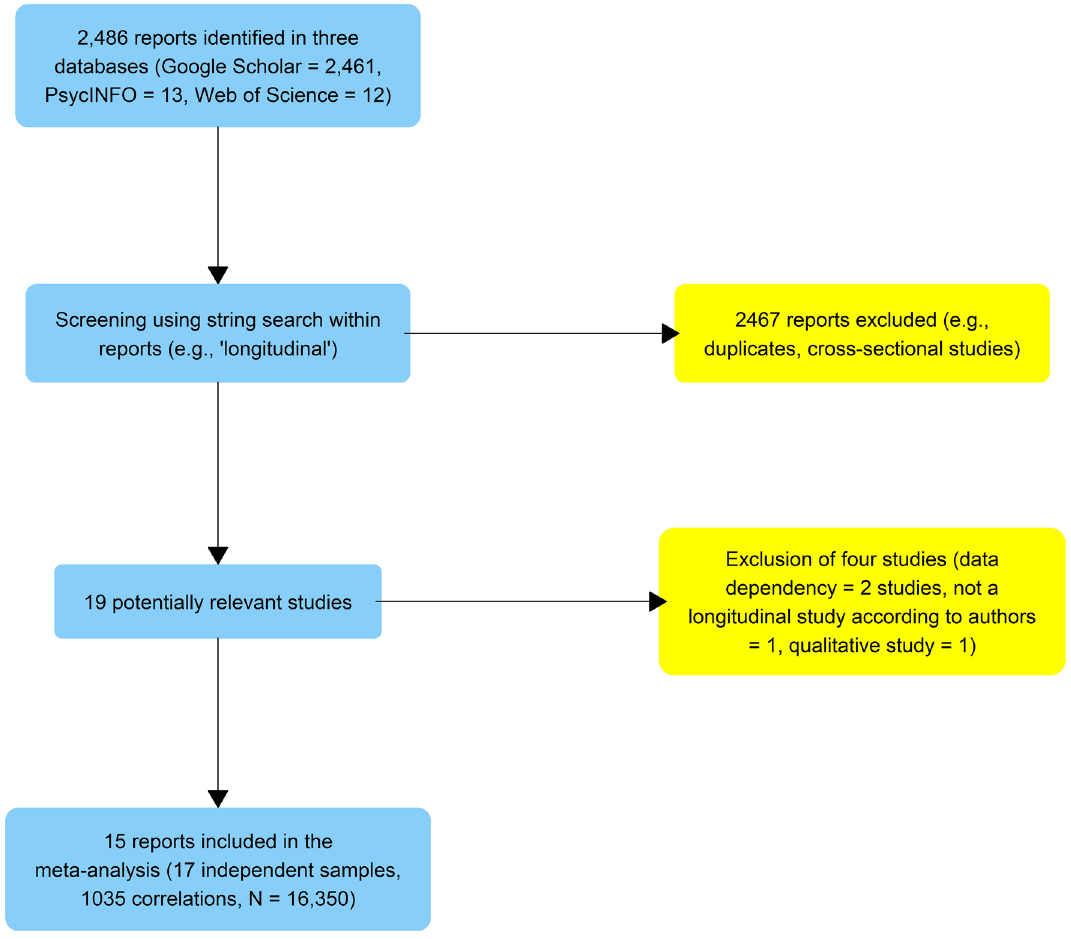
Figure 1. Flow chart summarizing the literature